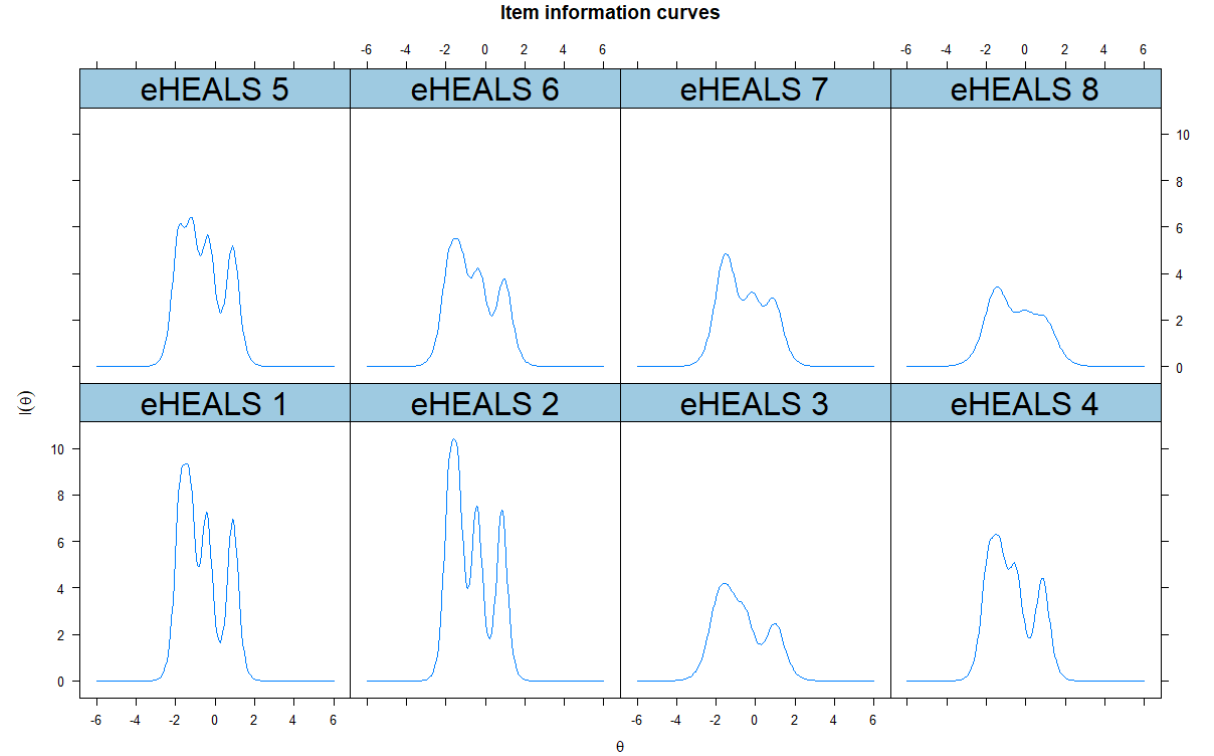
Figure 2. The item information curves for items of the simplified Chinese eHealth literacy scale. eHEALS: eHealth literacy